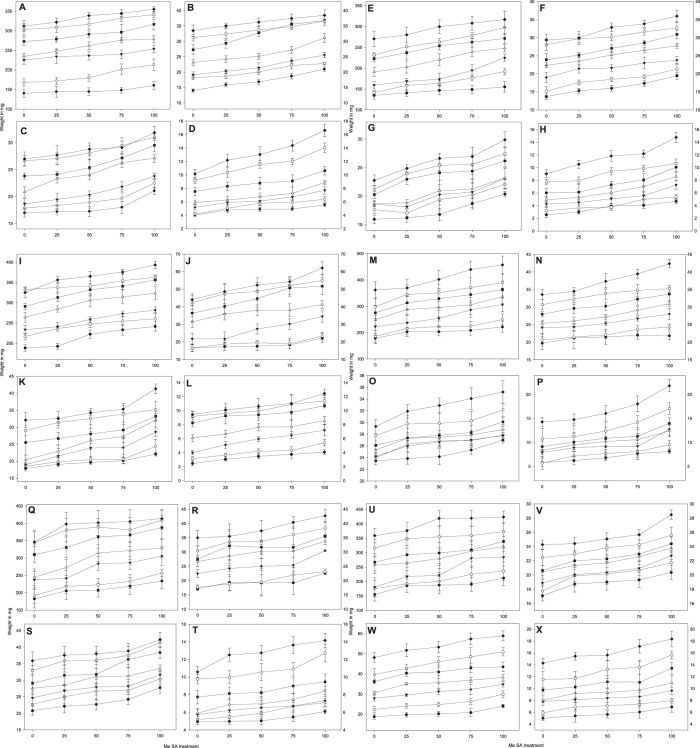
Fresh (A,E,I,M,Q,U) and dry (B,F,J,N,R,V) weight (mg) of shoot; fresh (C,G,K,O,S,W) and dry (D,H,L,P,T,X) weight (mg) of root of IR 20,IR 50, IR 64, ASD 16, ASD 19 and ADT 46 rice varieties after treatment with MeSA in greenhouse condition (-●-10th day -○- 12th day -▼- 14th day-△- 16th day -□- 18th day-■- 20th day -♦-22nd day) (MeSA treatment doses are mg/L).